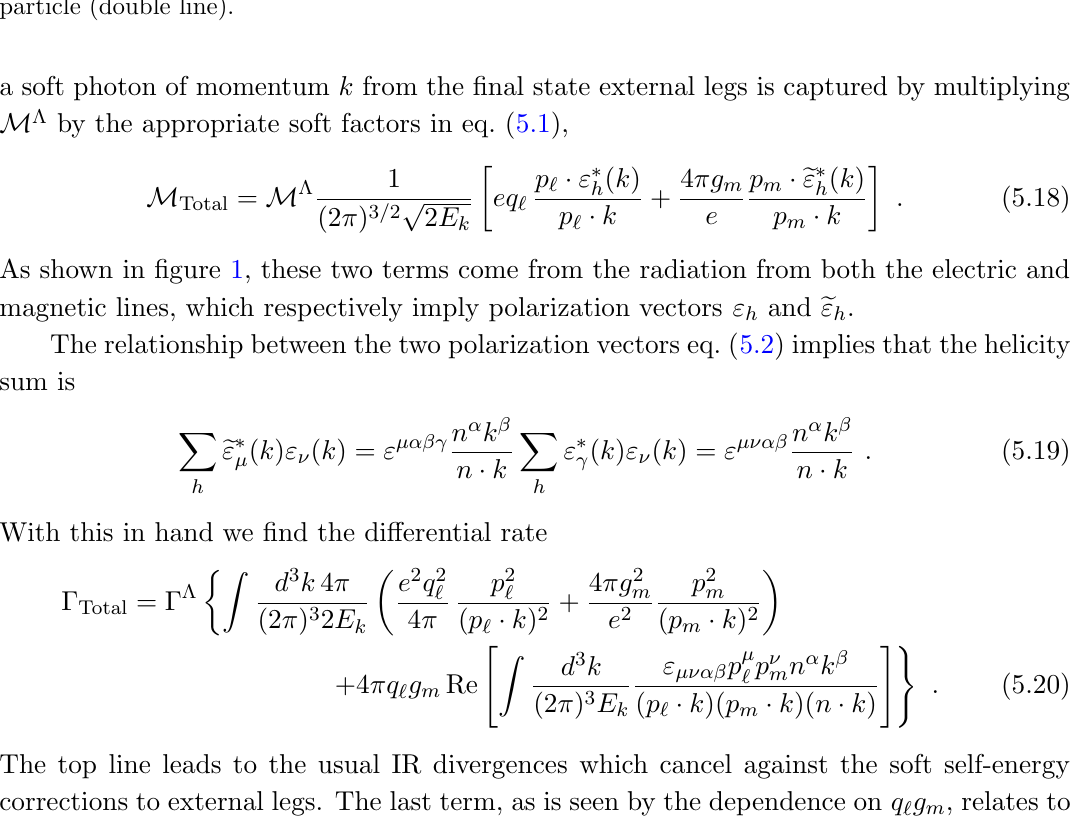
Figure 1 . The diagrams contributing to the emission of real soft photons to an unspeci(cid:12)ed hard scattering process between an electrically charged particle (thin line) and a magnetically charged particle (double